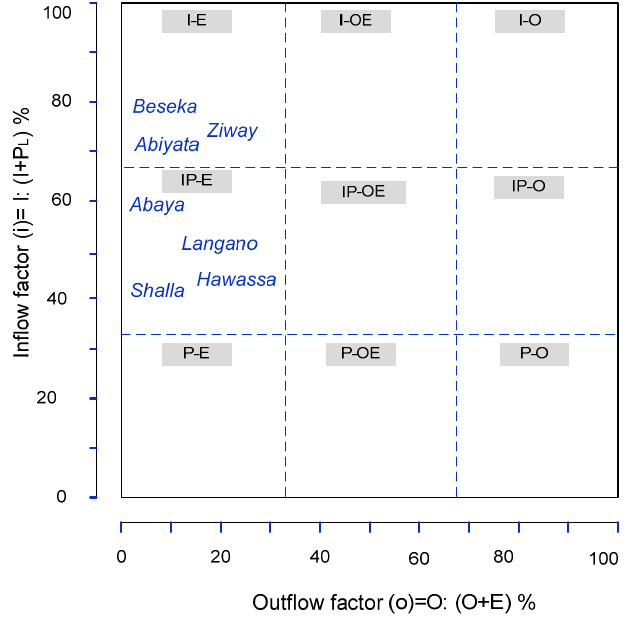
Figure 2 . Classification of lakes by water balance criteria (inflow-outflow). (N.B: Lake Chamo was not considered in this result due to limited data availability)